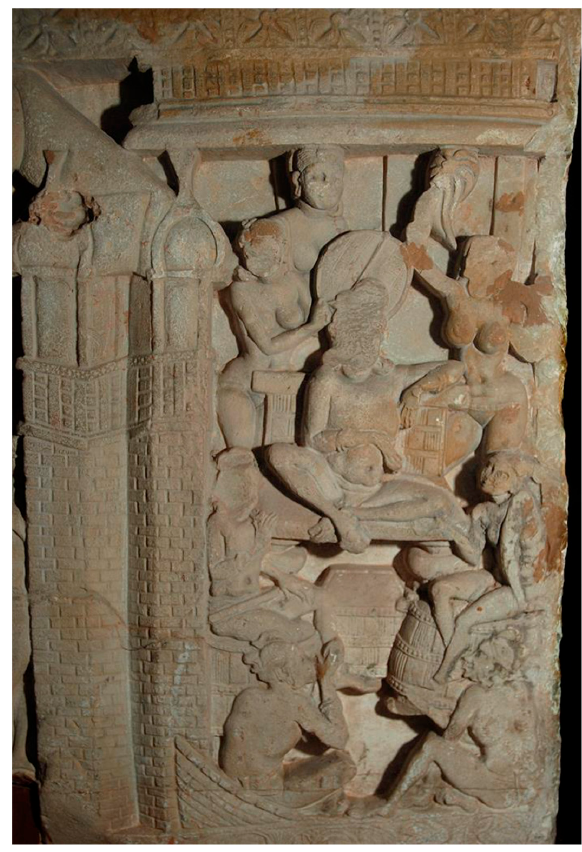
Figure 6. Part of relief no. 75 in Chennai Government Museum © photograph Wojtek